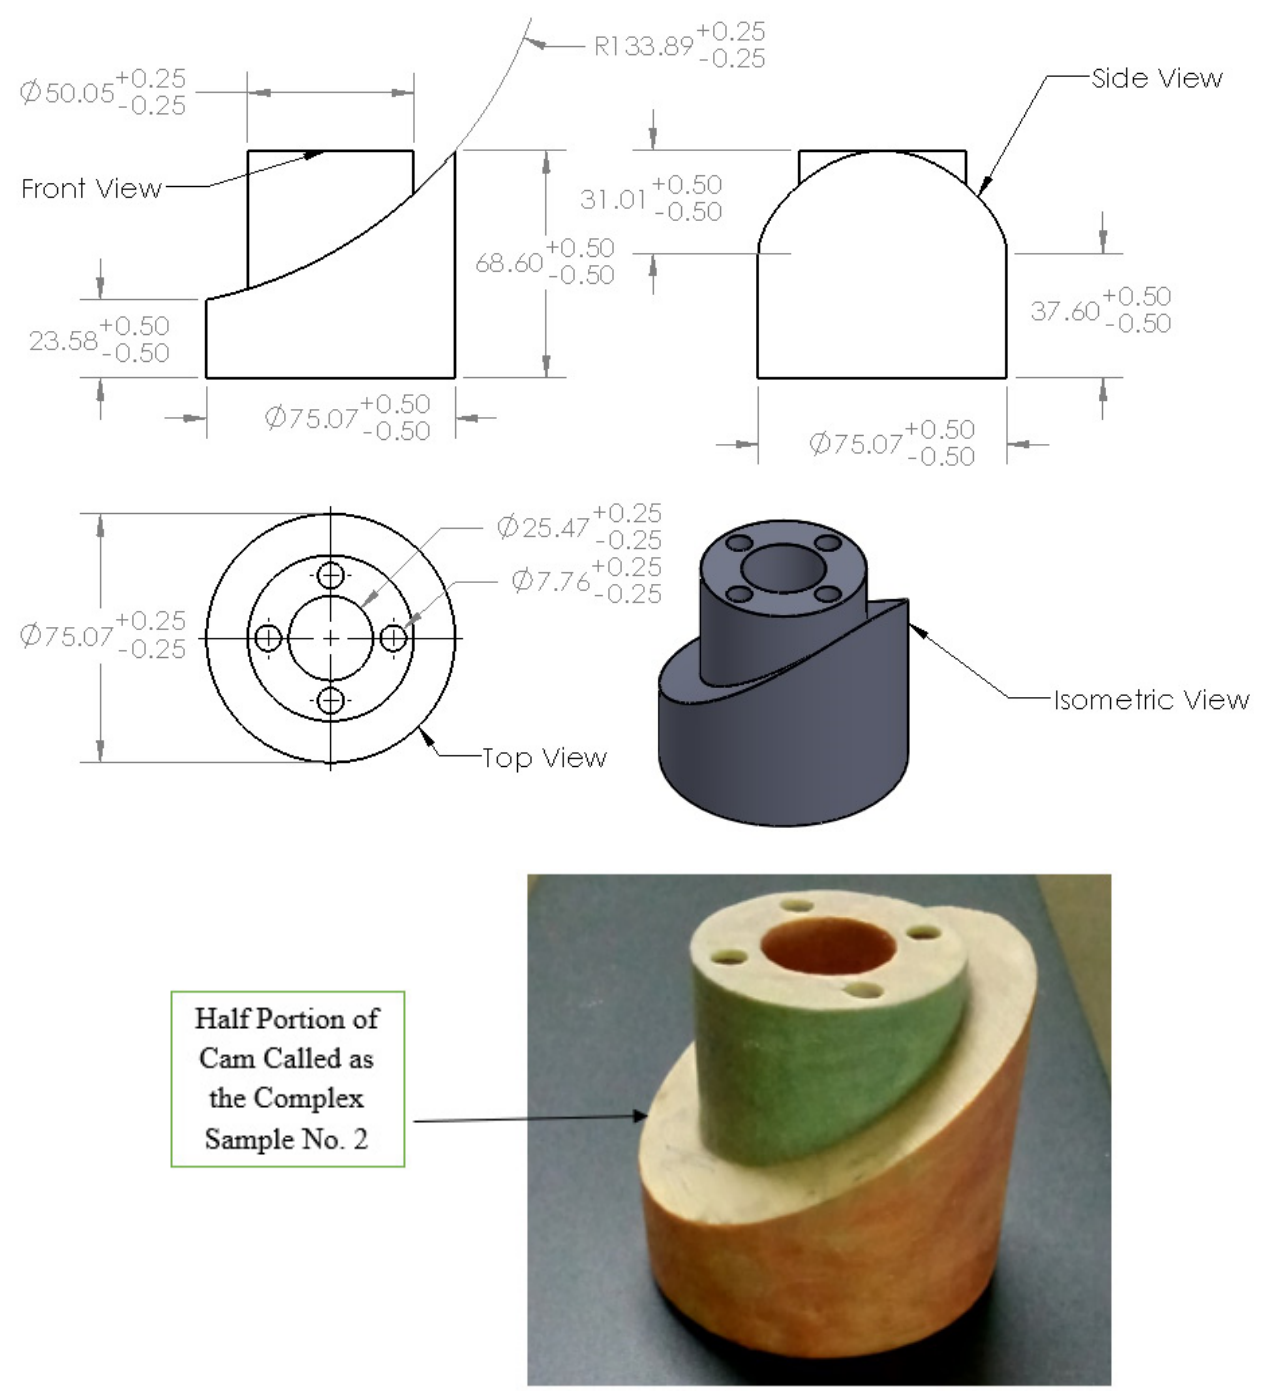
Figure 2. Geometric dimensions of complex object (S2)